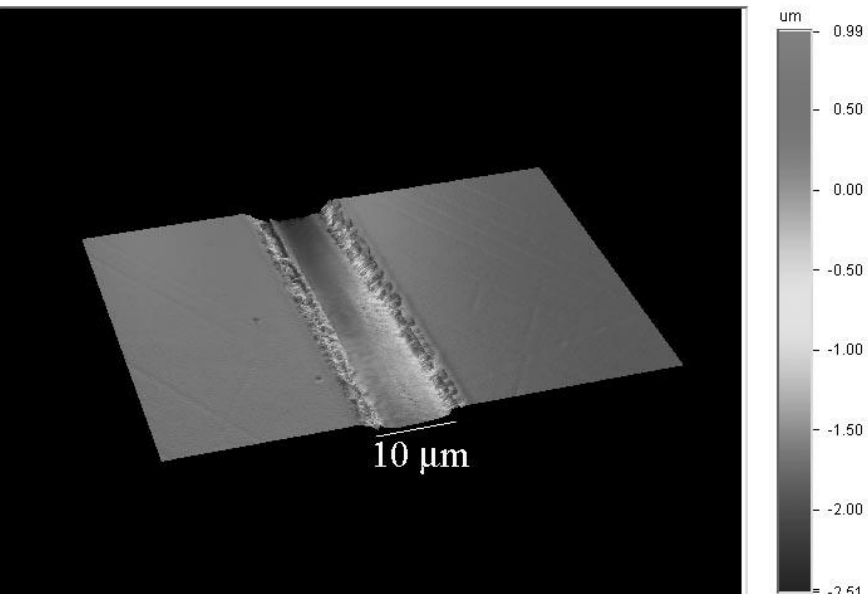
Figure 8. Three dimensional surface image of the as-grown liquid phase epitaxial layer on the machined lithium tantalate substrate from the optical profiler (Veeco, Bruker Nano Surface, Tucson, AZ, USA).